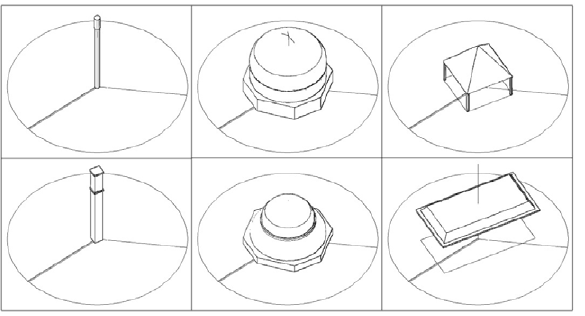
Figure 10. Totally, the elements manifested posterior to the center precincts have narrow vertical, circle- based, horizontal plane, and symmetric shapes